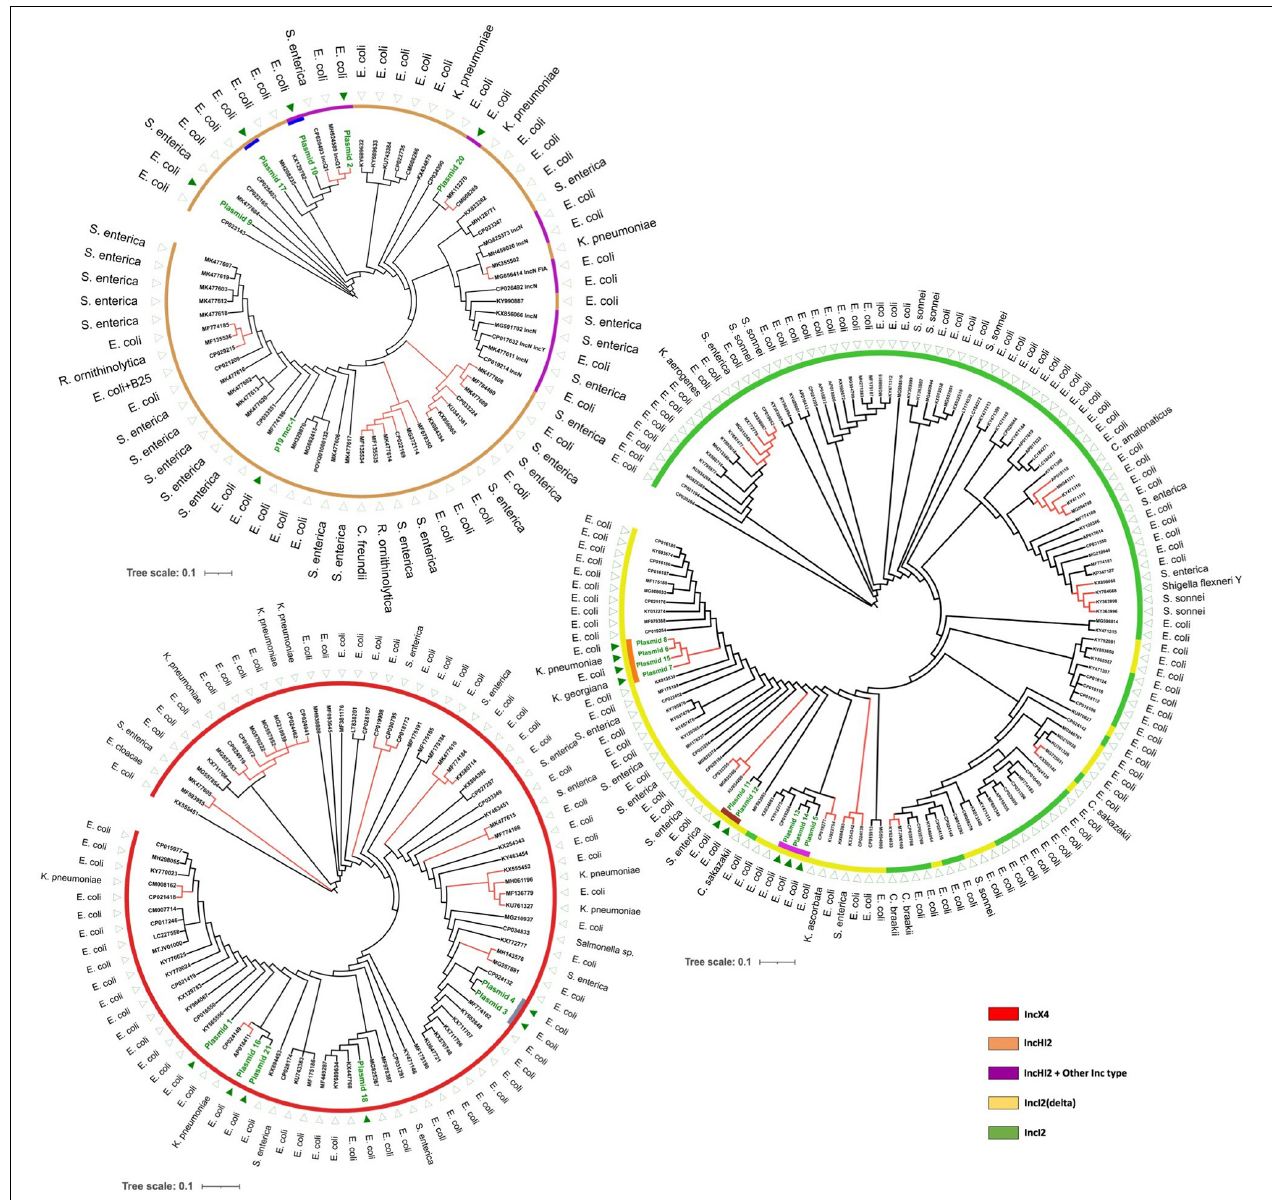
FIGURE 2 | Maximum likelihood trees based on SNP analysis (core and accessory SNPs) of mcr-1 -carrying plasmids using k-mers defined by kSNP. Separate figures are provided for plasmids of IncX4, IncI2/IncI2(delta), and IncHI2 (including IncHI2/IncQ1 and IncHI2/IncN). Dark green text and triangles are plasmids from this study isolates; colored bars indicate plasmids from the same patient, the color of the outer circles correspond to Inc types. Red branches indicate plasmid clusters involving different bacterial